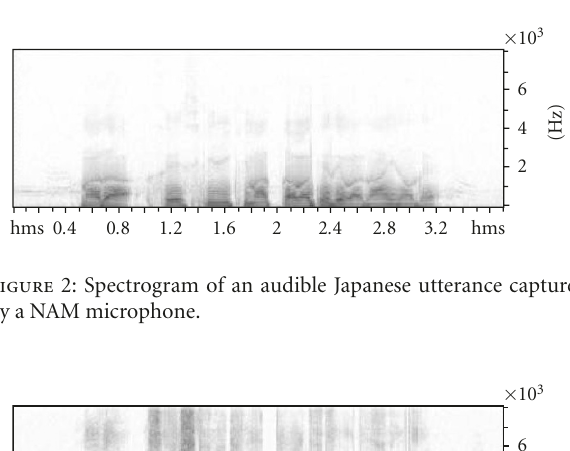
Figure 3: Spectrogram of an audible Japanese utterance captured by a close-talking